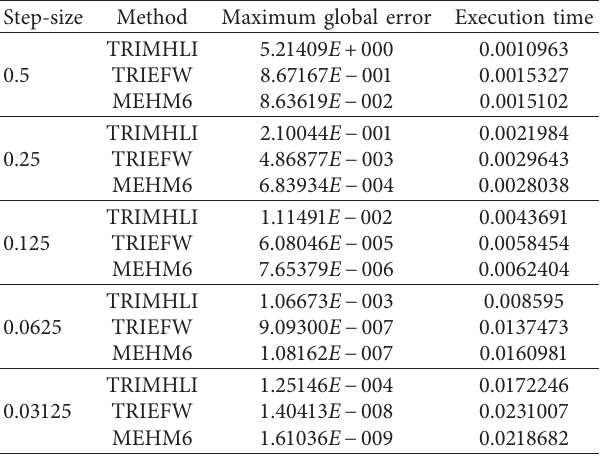
Table 3: Numerical results for Problem 3.